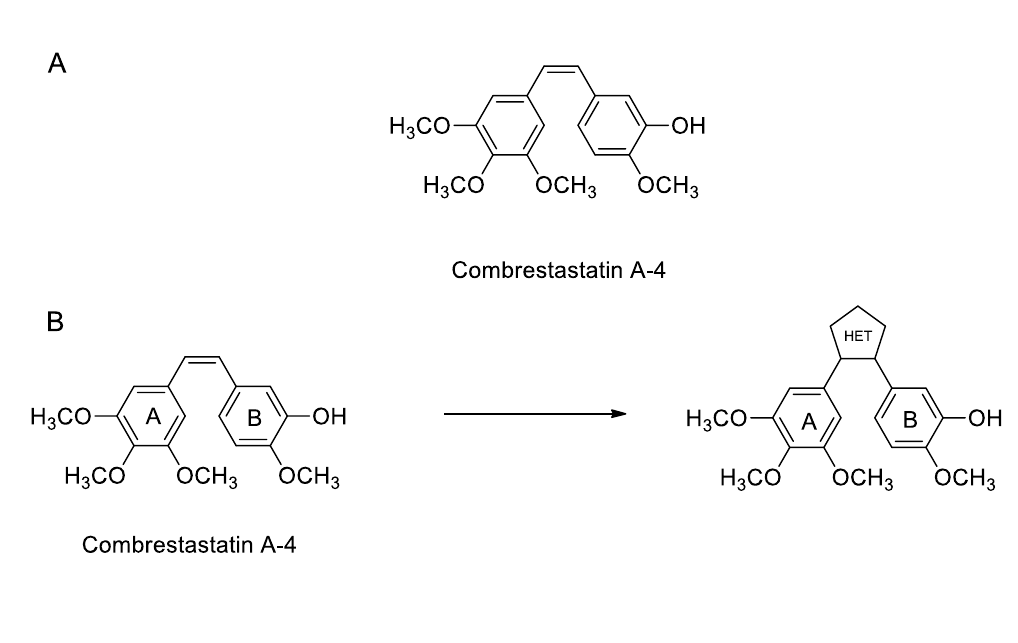
Figure 1. ( A ) Combretastatin A-4 structure; ( B ) Modified structural of combretastatin A-4.